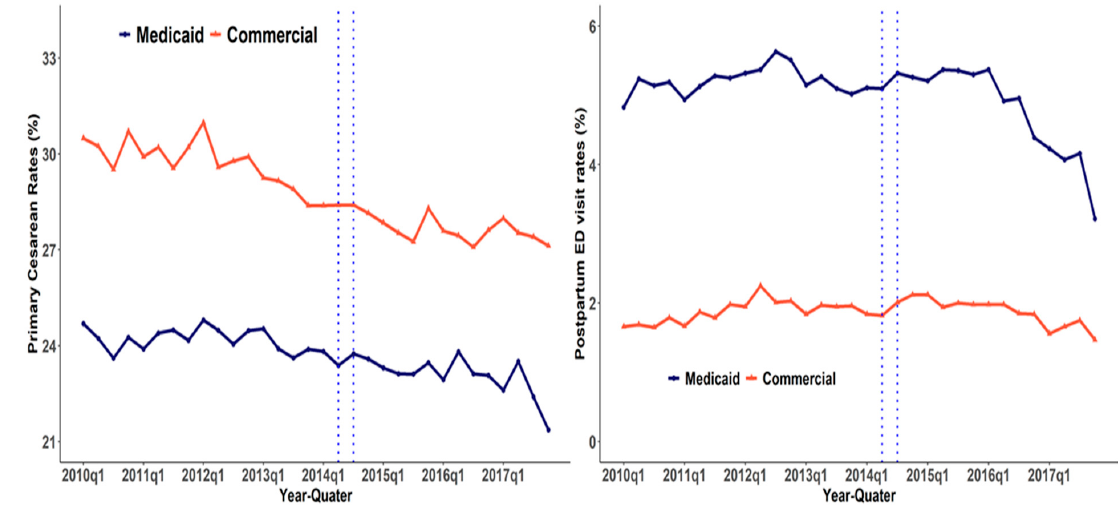
Figure 1. Trends in the primary cesarean rates and postpartum ED visits by payor.